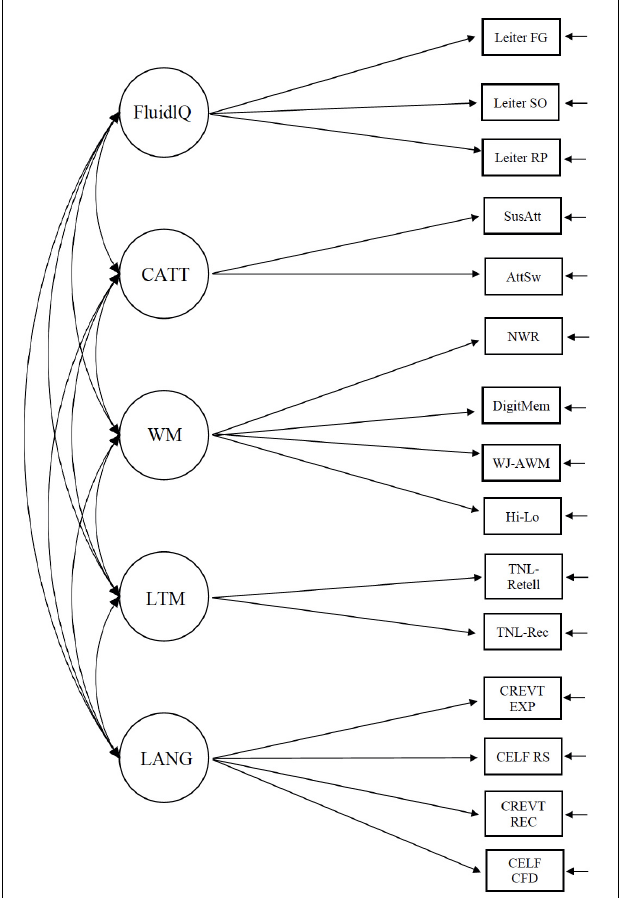
FIGURE 1 | The five-factor conceptual model containing the latent variables of fluid reasoning (FLDR), controlled attention (CATT), working memory (WM), long-term memory – language knowledge (LTM-LK) and language